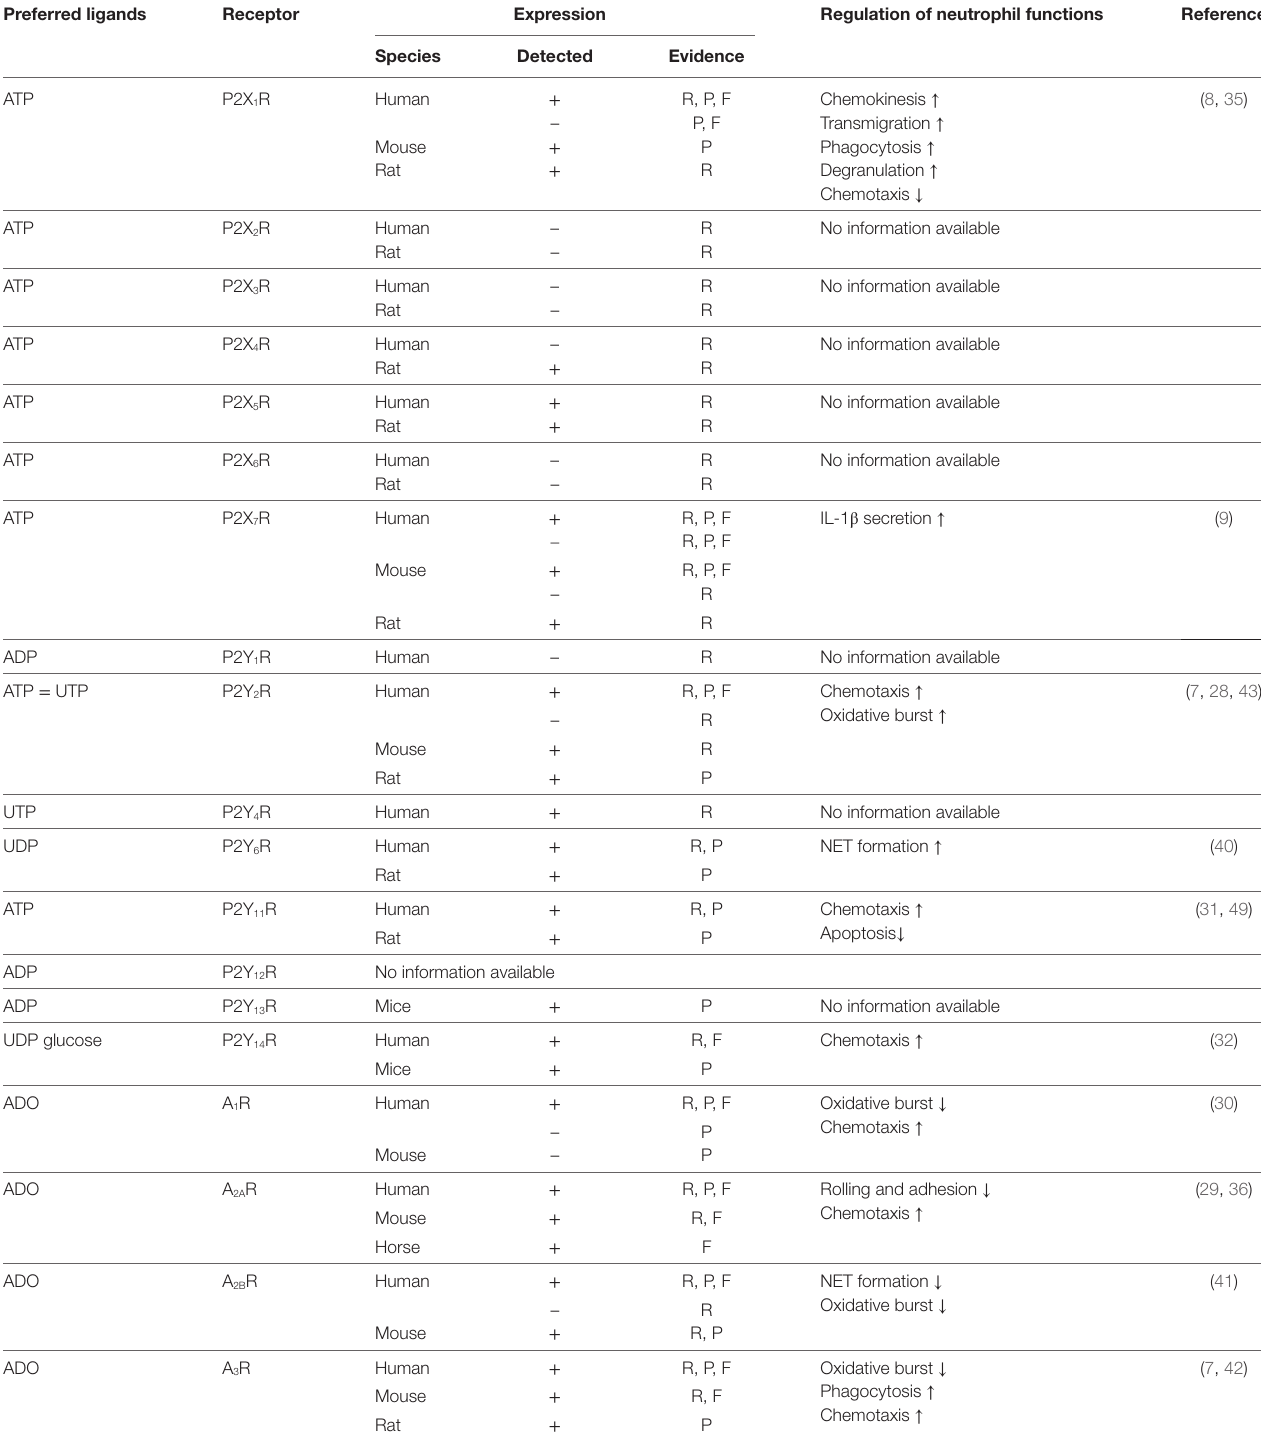
TABLe 1 | Expression and/or function of purinergic receptors in